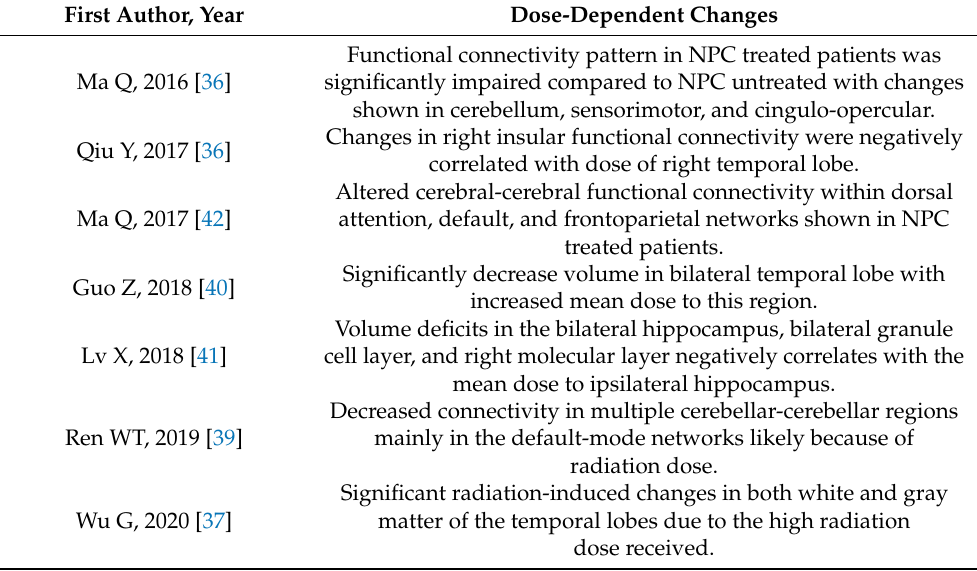
Table 4. Dose-dependent changes with brain microstructure or functional